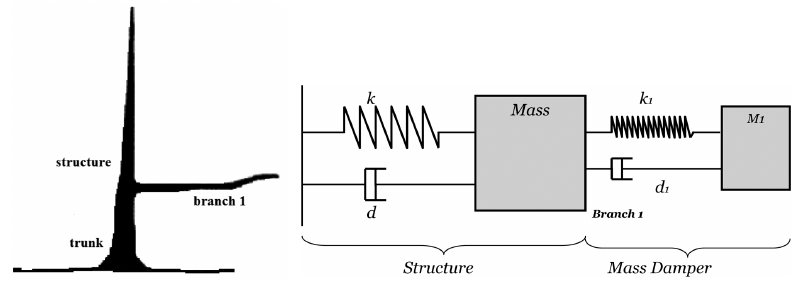
Fig. 3. Dynamic model of a trunk with branch (mass damper)